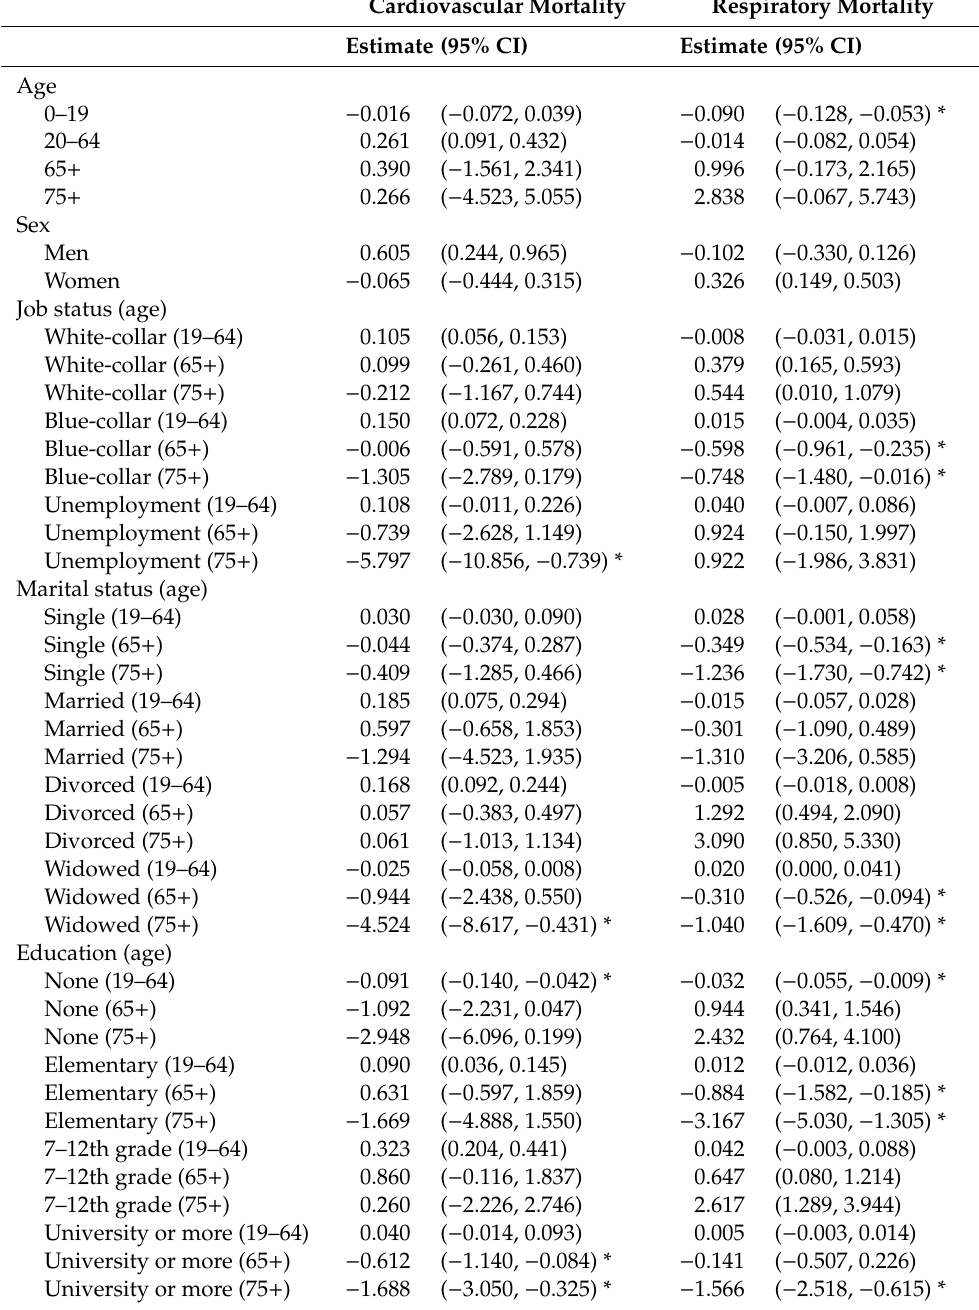
Table 3. E ff ects of the heat wave warning system on changes in cardiovascular and respiratory mortality based on the comparison of mortality changes due to heat wave alert announcements for heat wave days versus non-heat wave days (i.e., counter factual) in 2009–2014 (mortality per 1,000,000 people per